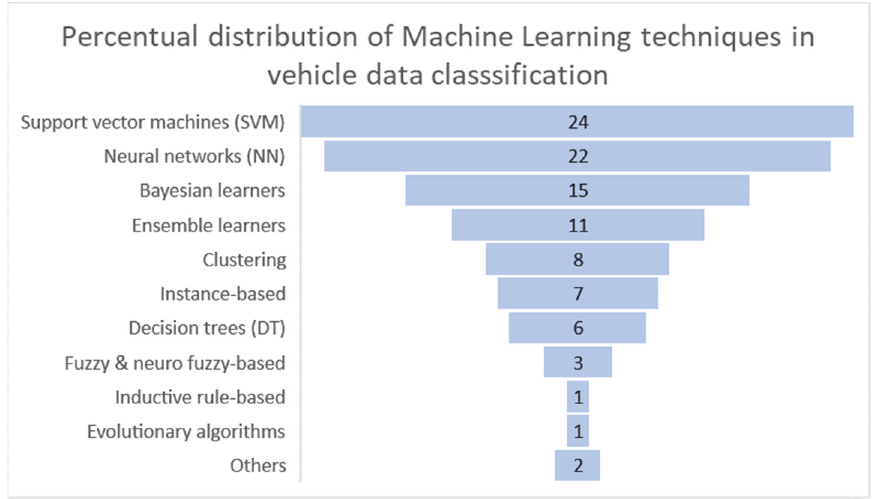
Figure 1. Distribution of ML technique used in vehicle data classification (Data by Elassad et al. [9]).